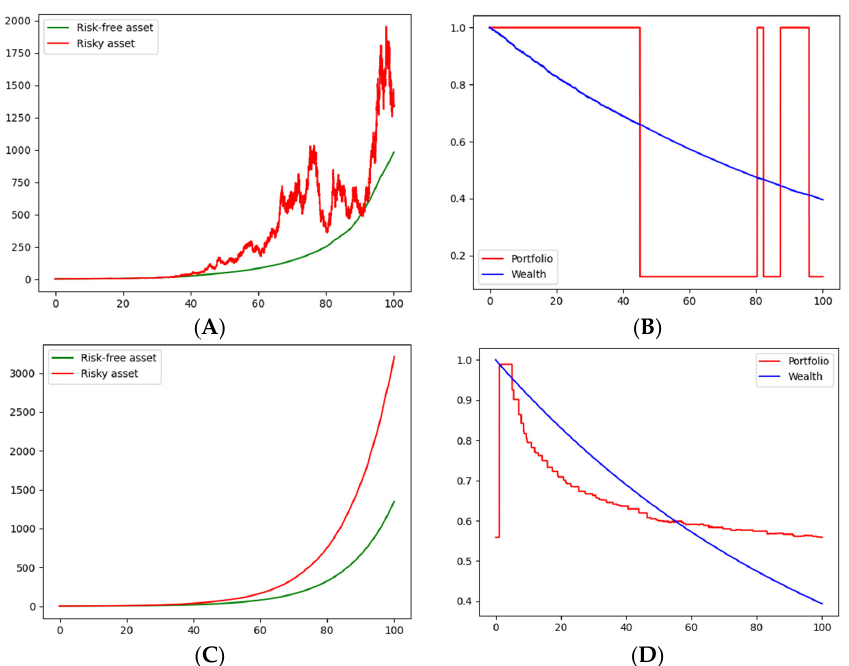
Figure 1. First scenario, logarithmic utility, k = 2, k (cid:48) = 1.5, and a 0 = r 0 = S 0 = X 0 = 1. Natural momentum ( µ 1 = 0.12, r 1 = 0.08, σ 1 = 0.2 ) vs. inferred momentum ( µ 2 = 0.06, r 2 = 0.055, σ 2 = 0.2 ) , with ρ = 0.01. ( A ) Price realization, ( B ) Portfolio strategy, ( C ) Average of price realizations, and ( D ) Average of portfolio strategies. Authors’ own elaboration.